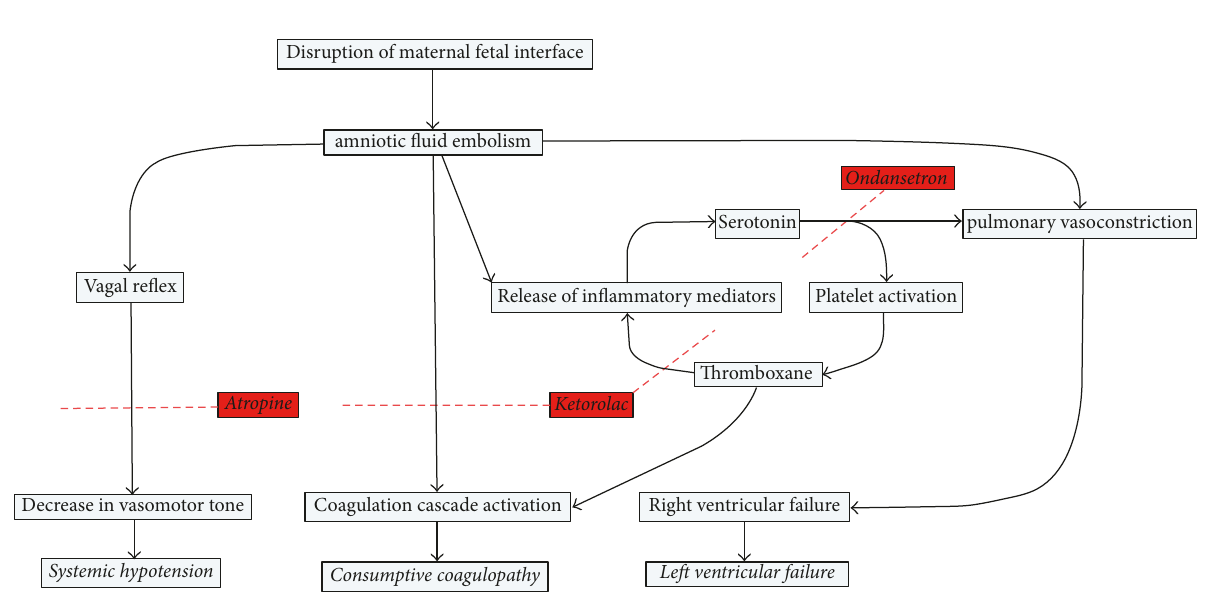
Figure 1: Proposed mechanism for Atropine, Ondansetron, and Ketorolac (A-OK)